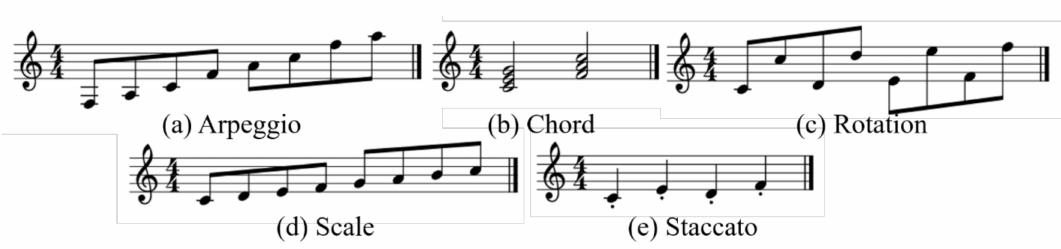
Figure 4. Representative piano playing techniques. ( a ) Arpeggio is a technique of playing the chords in rising or descending order from a low note to high; ( b ) chord is a set of more than one note; ( c ) rotation is a technique of playing two notes with a leap using the rotation of the front arm; ( d ) scale is a technique of playing the notes in one octave in order; ( e ) staccato is a technique of playing the notes with a short